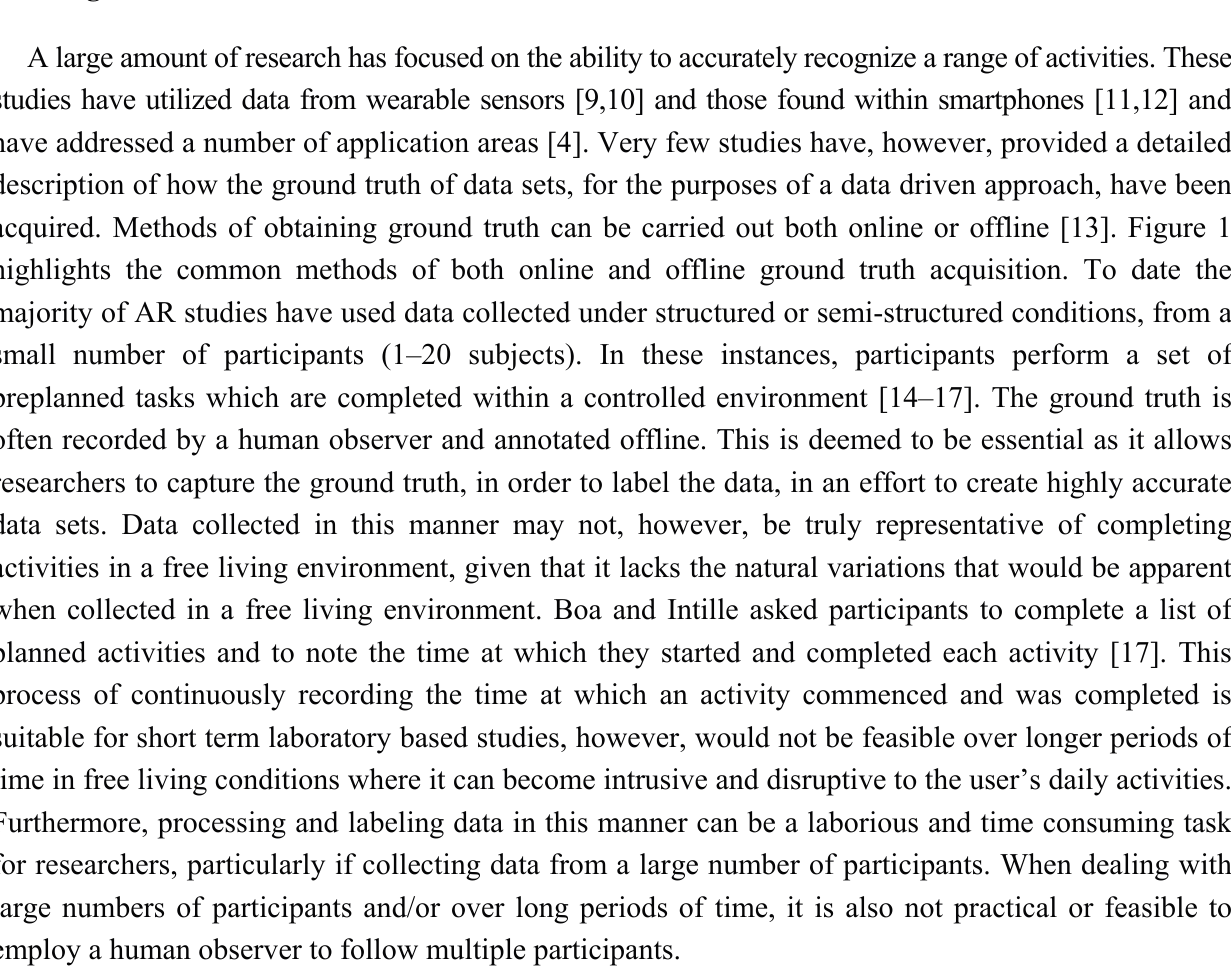
Figure 1. Common methods of ground truth acquisition, highlighting the tradeoff between time required and label accuracy. Figure has been redrawn from [13]. Prompted labeling denotes the method proposed within this